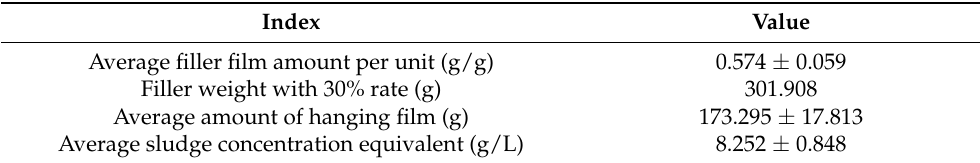
Table 3. Reactor hanging film